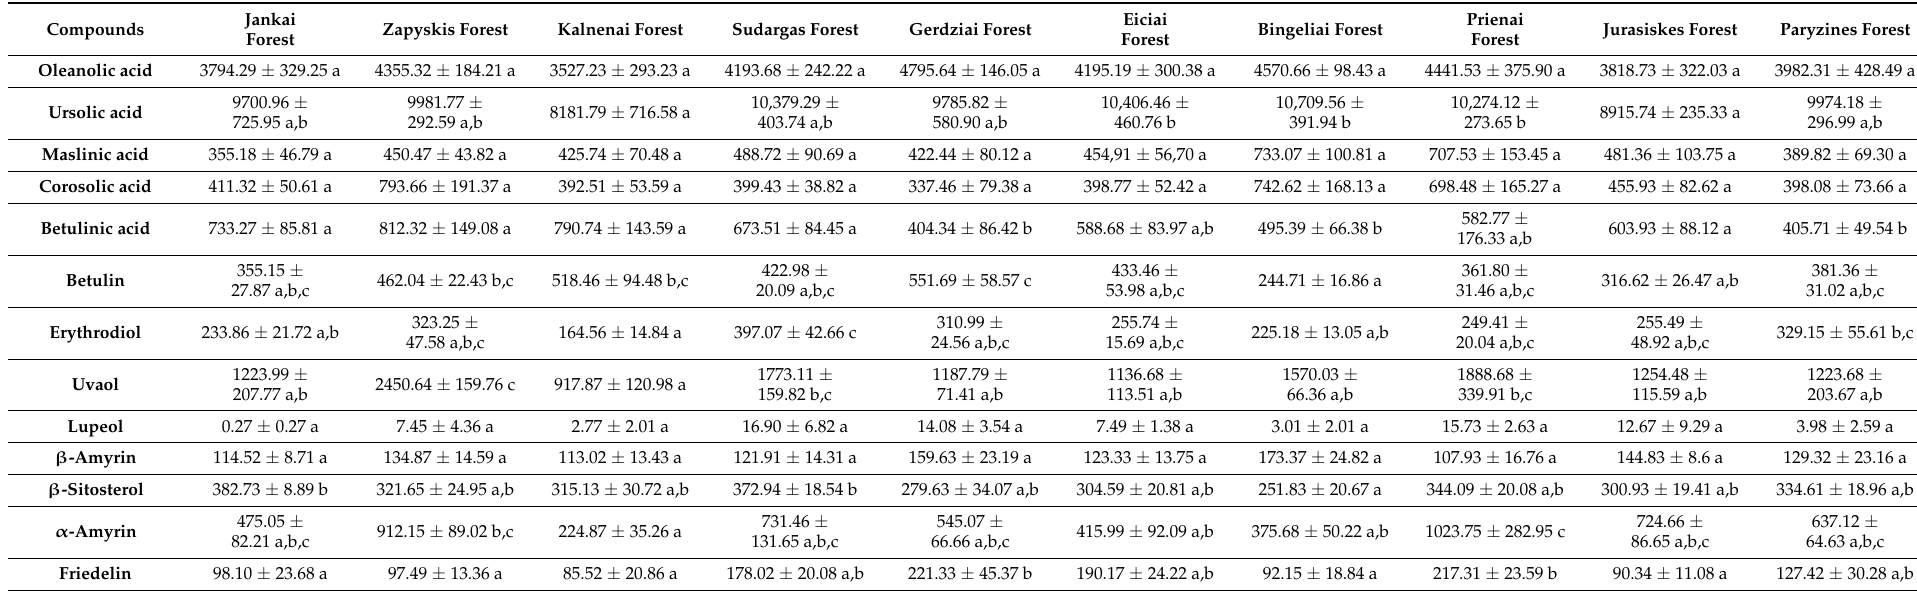
Different letters indicate statistically significant differences in the content of triterpenic compounds between different heather